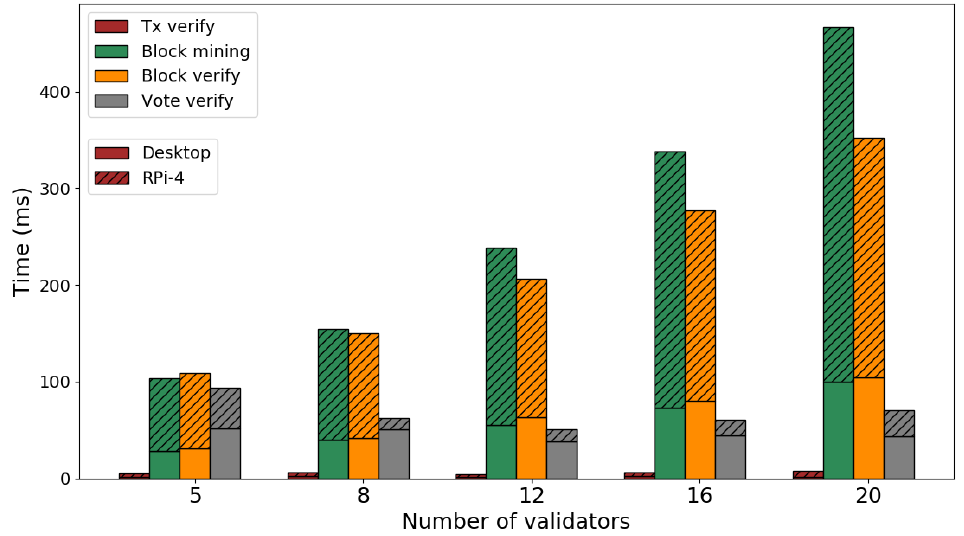
Figure 5. Computation overhead for stages of running PoENF consensus on host. Comparative evaluations on platform